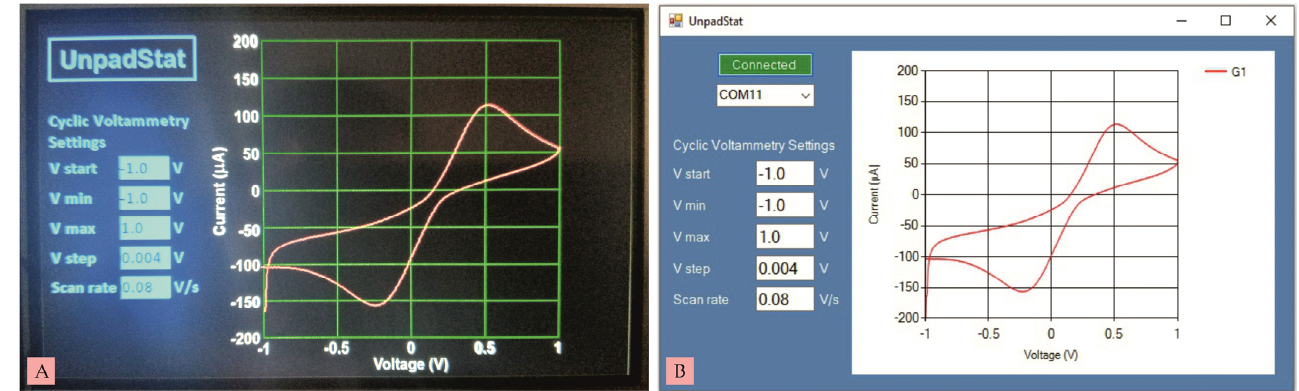
Figure 8. ( A ) CV measurement on commercial SPCE using Nextion, ( B ) CV measurement on com- mercial SPCE using computer.